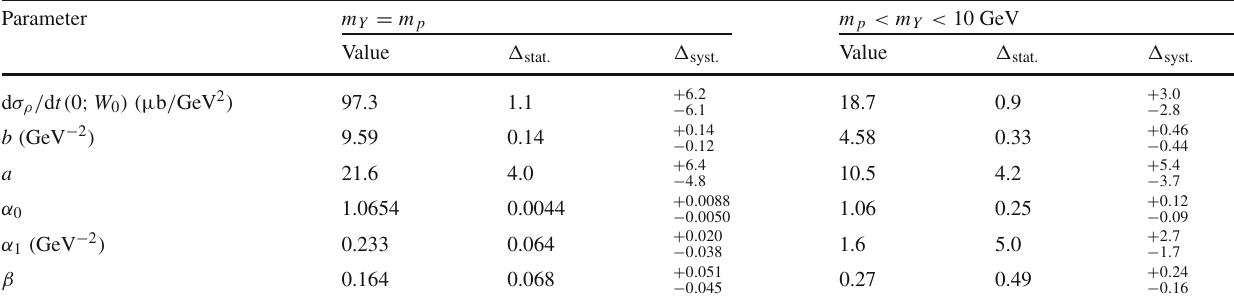
and statistical and systematic uncertainties are given. A full uncertainty breakdown and statistical correlations are provided [77]. The corre- sponding fit is shown in Fig. 17